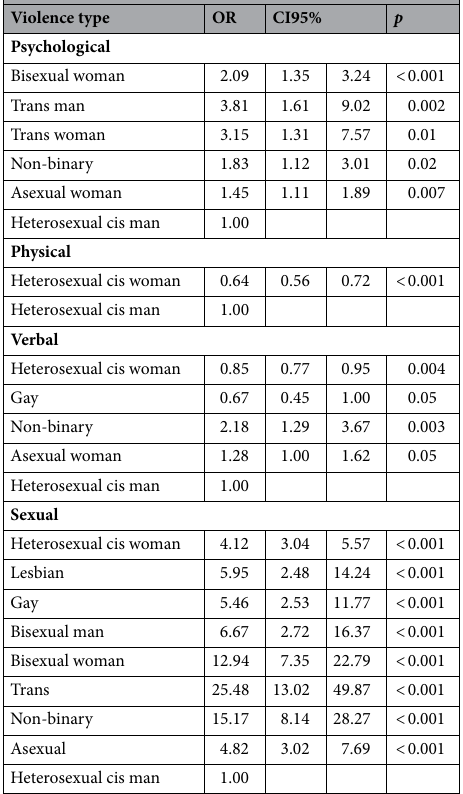
Table 3. Predictive effect of Group on psychological, physical, verbal, or sexual violence. OR odds ratio, CI confidence interval. Only statistically significant comparisons are